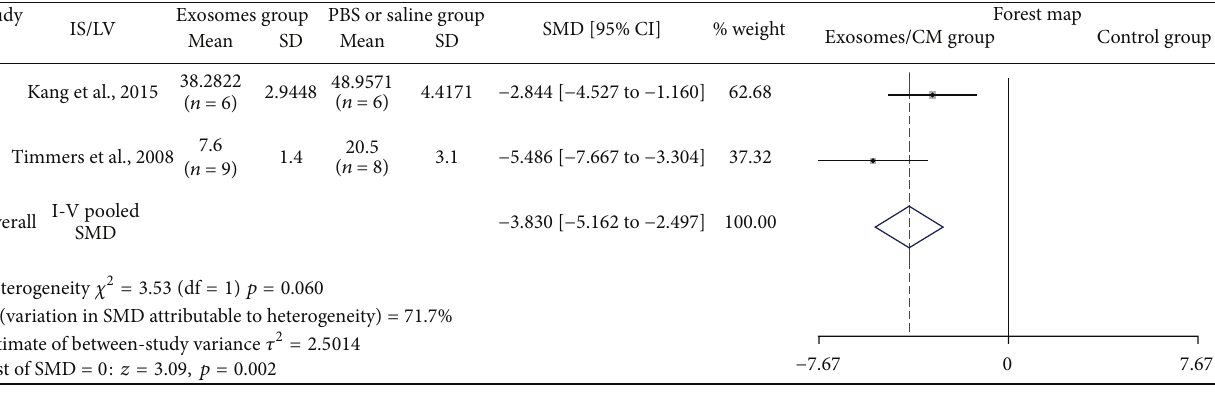
Figure 4: The effectiveness of exosomes on IS/LV.